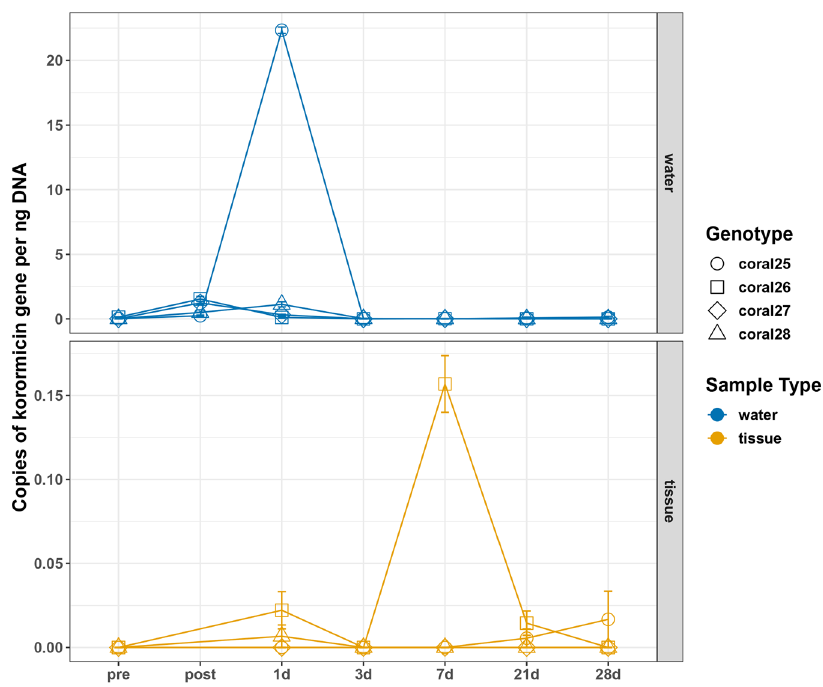
Fig. 6 Detection of korormicin gene copies over time after inoculation with Pseudoalteromonas McH1-7. Points show the mean copy number per ng of DNA of the Kor23 gene from triplicate reactions of ddPCR and the standard error is shown by the error bars. “ Pre ” indicates samples taken before inoculation with the probiotic strain McH1-7. “ Post ” indicates samples taken one hour after inoculation in water samples only. Each M. cavernosa genotype was cut into six fragments prior to the experiment and one fragment was sacri fi ced at each time for genetic analysis. Note the difference in the y-axis scales, as higher copy numbers were detected in the water compared to tissue